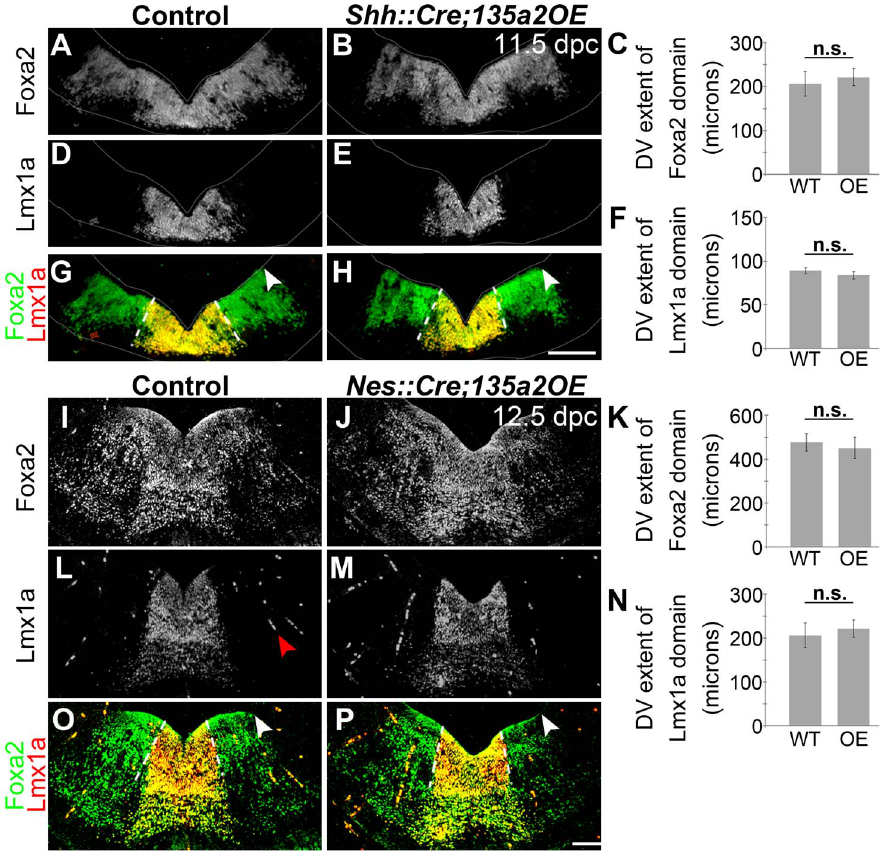
Figure 11. Increasing miR135a2 levels after an early critical window has no effect on mDA progenitor domain size. (A–H) Immunolabeling of 11.5 dpc Shh::Cre;135a2OE embryos, in which recombination begins at the ventral midline at , 8.5 dpc, revealed no change in the dorsal-ventral extent of either the Foxa2 or Lmx1a progenitor domains. The closed white arrowheads indicate the dorsal border of Foxa2 expression, graphically represented in C (n=3; control mean=229.34 6 6.51 m M, mutant mean=221.17 6 10.68 m M; p-value=0.55). The dotted white lines indicate the dorsal border of Lmx1a expression, graphically represented in F (n=3; control mean=89.09 6 3.49 m M, mutant mean=83.72 6 4.13 m M; p-value=0.38). The sections were outlined to accentuate tissue. (I–P) Similarly, analysis of 12.5 dpc Nes::Cre;135a2OE , in which recombination occurs throughout the region at , 10.5 dpc, revealed no change in the dorsal-ventral extent of either the Foxa2 or Lmx1a progenitor domains. The closed white arrowheads indicate the dorsal border of Foxa2 expression, graphically represented in K (n=3; control mean=478.03 6 39.89 m M, mutant mean=451.67 6 48.67 m M; p-value=0.41). The dotted white lines indicate the dorsal border of Lmx1a expression, graphically represented in N (n=3; control mean=205.64 6 27.89 m M, mutant mean=221.29 6 19.84 m M; p-value=0.39). The red arrowhead in L points to background staining found in blood vessels outside the mDA domain. Scale bars represent 100 m M.